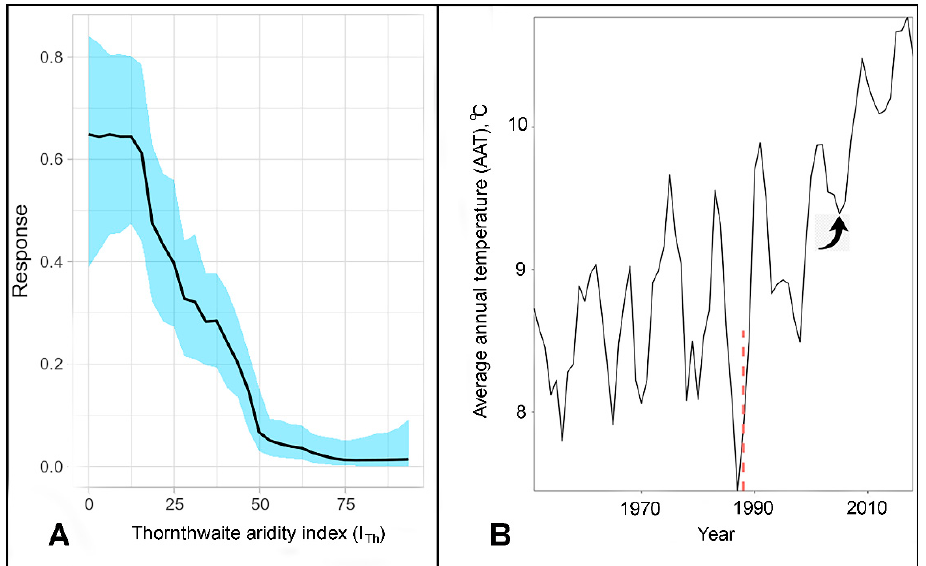
Figure 6. ( A ) Partial dependence plot for predictor: Thornthwaite aridity index (I Th ); dimensionless. ( B ) Dynamics of the average annual temperature (AAT) in Kyiv for 1950–2017; x -axis — years, y - axis—AAT (°C); the red dotted line indicates 1988 (‘breakpoint’), after which there is a steady ten- dency to rising AAT; the arrow marks the time of the first appearance of P. robiniella in Kyiv (2003).